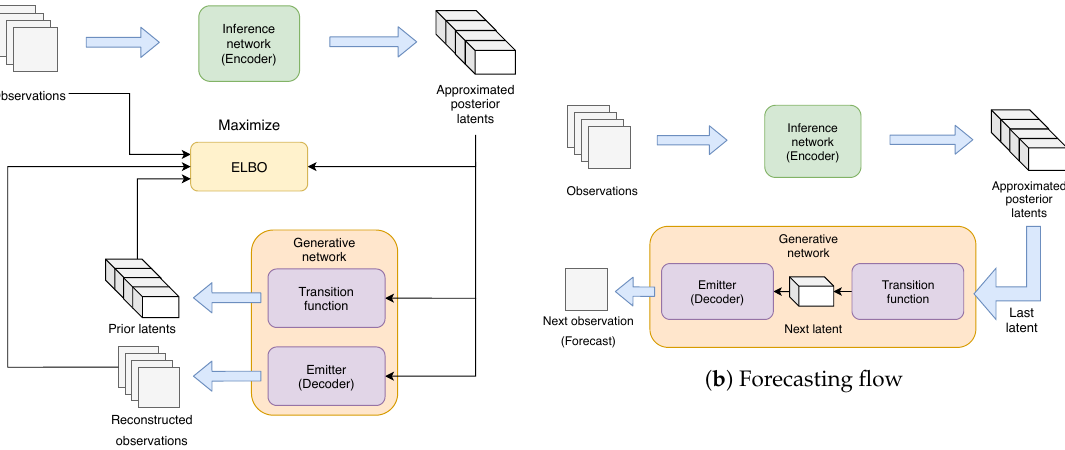
Figure 3. Figure 3a shows the training flow of our approach. The observations are first fed into the inference network to produce a series of approximated posterior latents. These latents are then inputted into transition function to produce a shifted series of prior latents. The approximated latents are also inputted into emitter to produce reconstructed observations. Finally, the original and reconstructed observations, along with approximated posterior and prior latents are used to calculate the evidence lower bound (ELBO) as the objective function. Figure 3b shows the one-step forecasting flow of our method. Similar to training flow, the observations are first inputted into inference network to produce posterior latents. We then use the last latent data to produce the next latent using transition function and calculate the next forecast using the emitter. We repeat this flow as new observations are obtained until the desired forecast length is